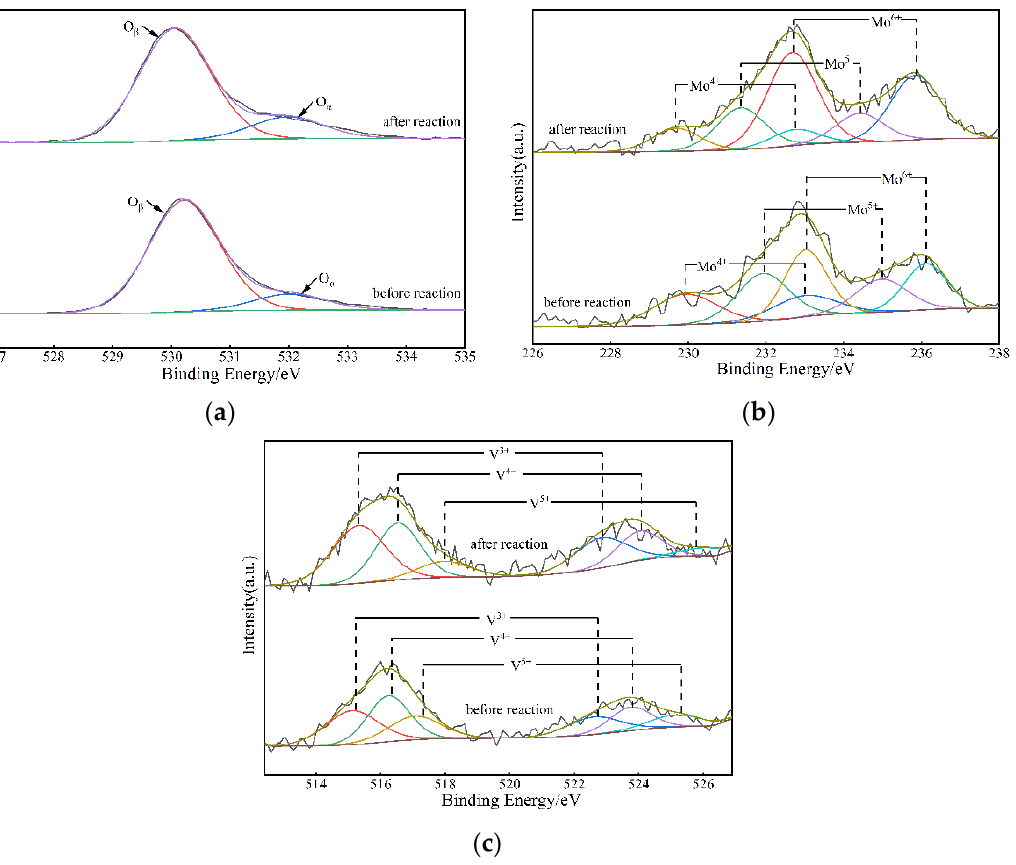
Figure 9. Deconvoluted XPS spectra of the V 1.6 Mo 1.7 W 1.8 /TiO 2 before and after reaction: ( a ) O1s; ( b ) Mo3d; ( c )